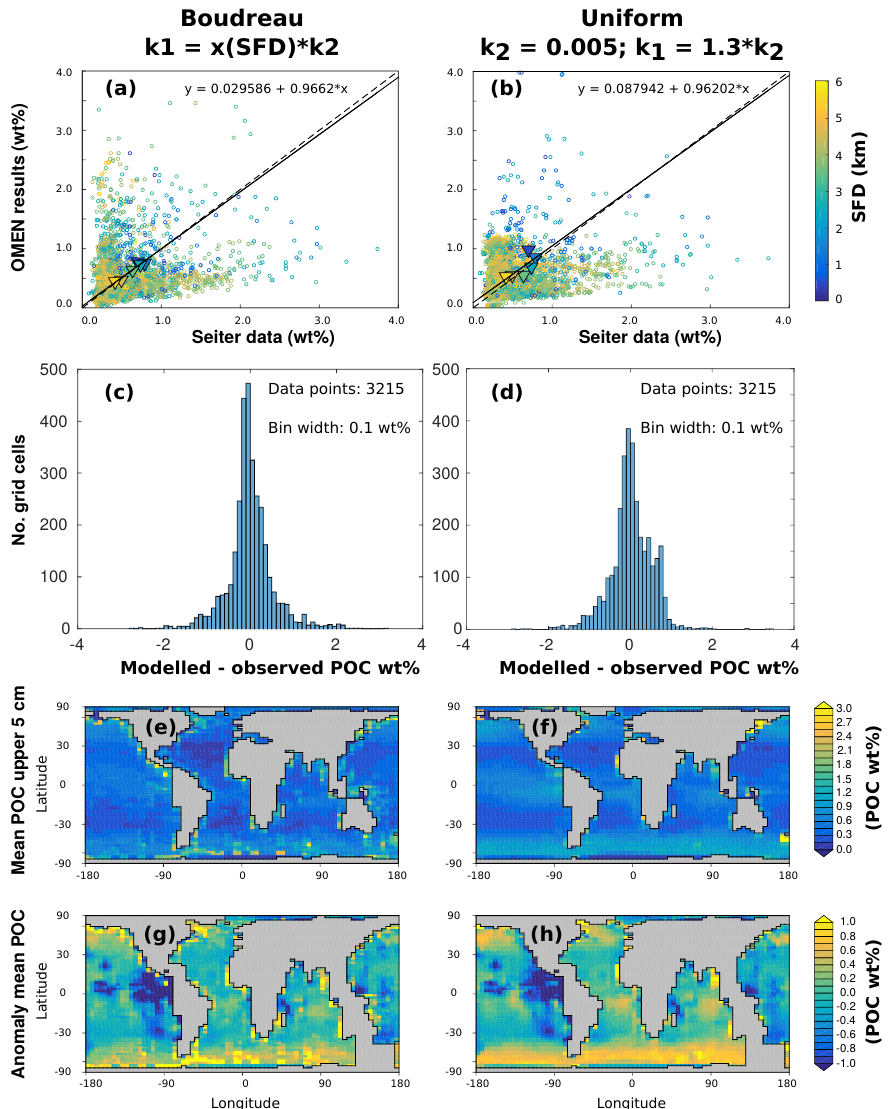
Figure 13. Mean POC concentrations in the upper 5cm of the sediments (POC 5cm ) using the depth-dependent parameterisation k 1 = x( SFD ) · k 2 adapted from Boudreau (1997, left) and the globally uniform model ( k 2 = 0 . 005, k 1 = 1 . 3 · k 2 ; right). (a, b) Cross plots as shown in Fig. 12. (c, d) Histograms of the residuals of modelled minus observed POC 5cm . (e, f) POC 5cm as calculated with OMEN-SED. (g, h) Difference map of POC 5cm as calculated with OMEN-SED and interpolated data from Seiter et al.